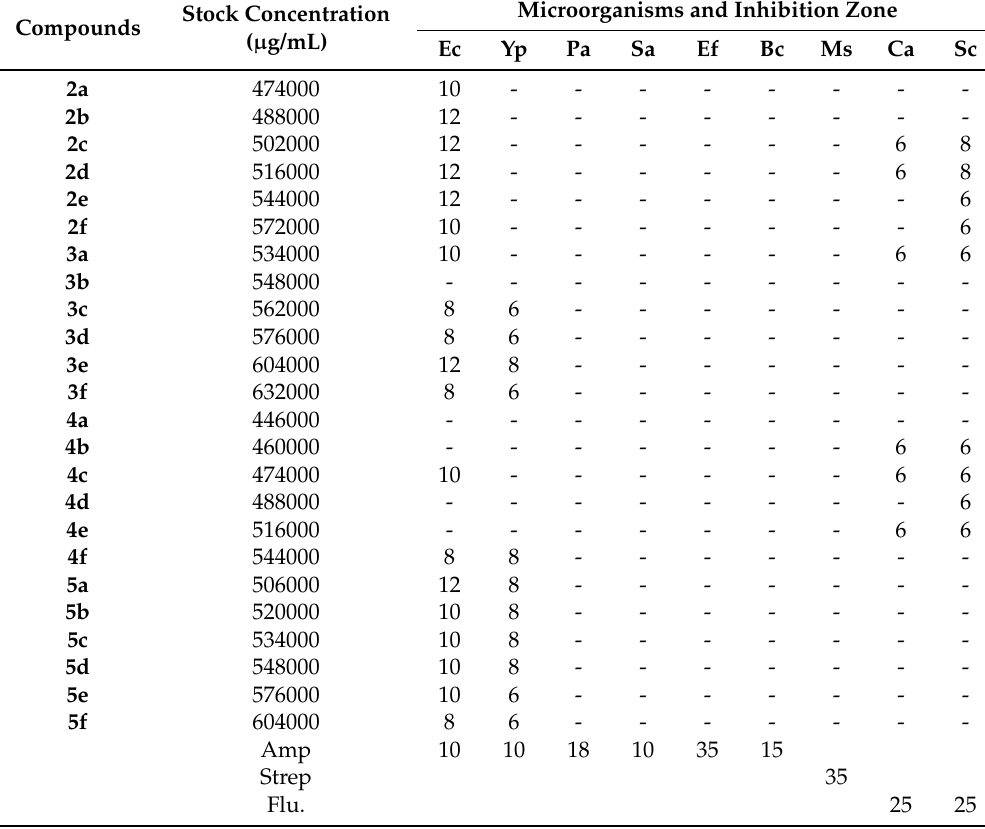
Table 2. Screening for antimicrobial activity of the compounds ( µ g/ µ L).